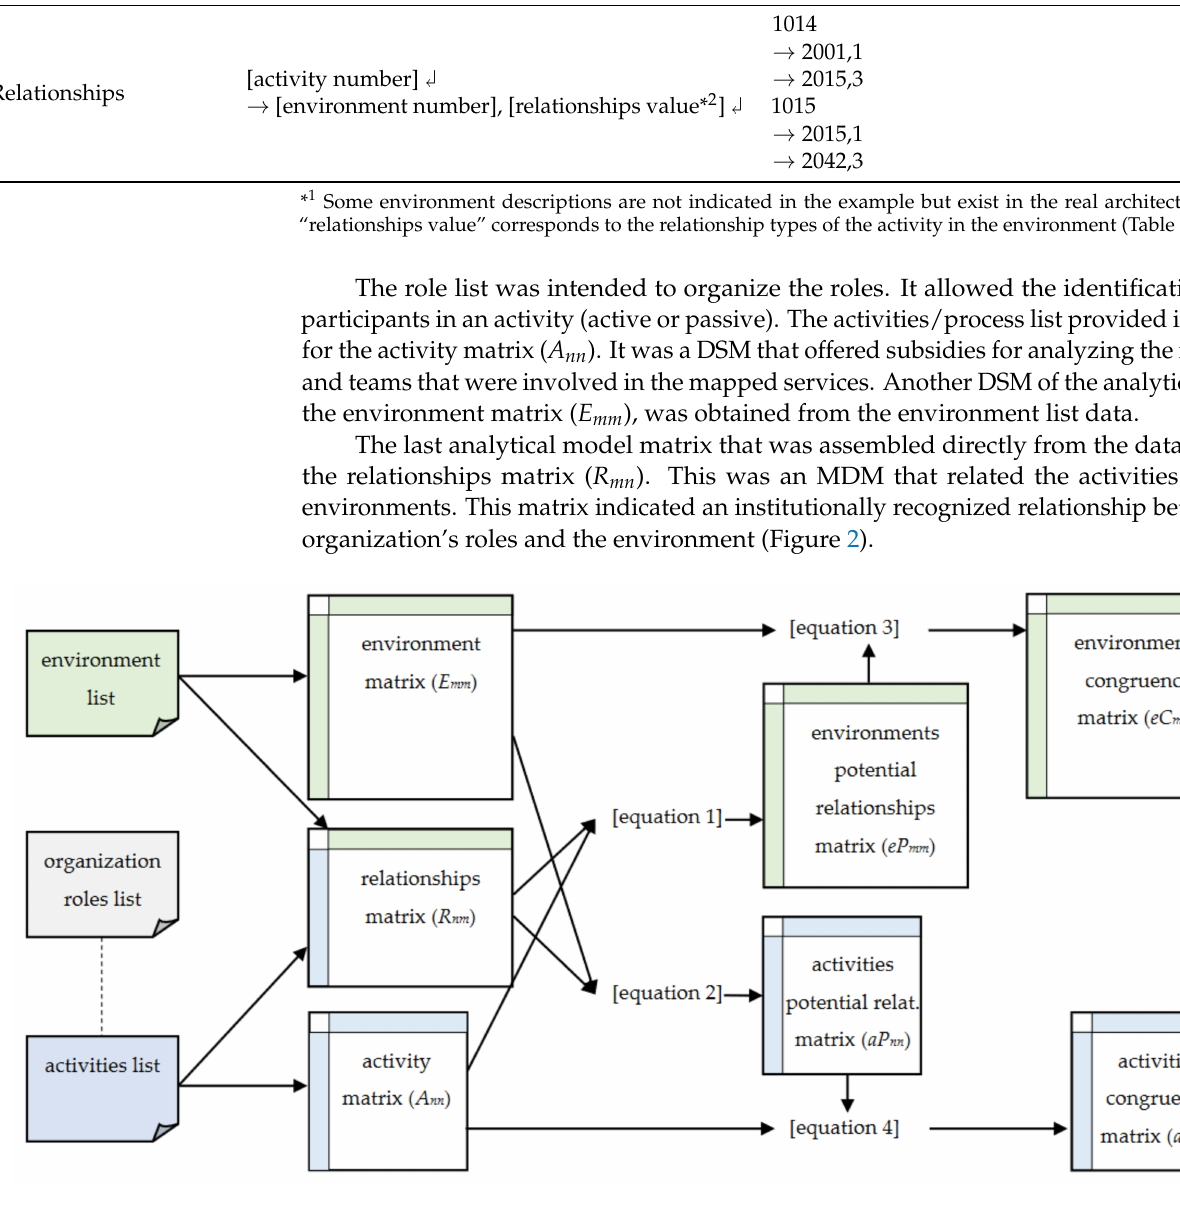
Figure 2. Analytical model